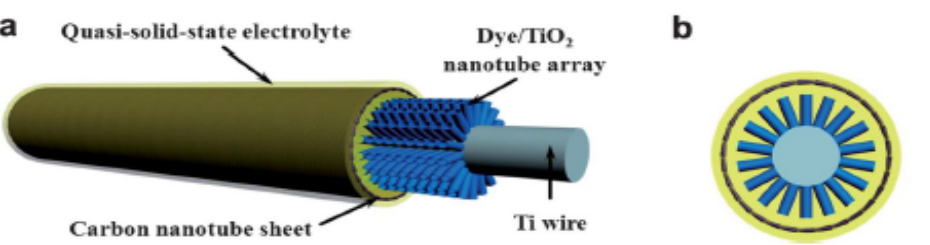
Figure 2. Three-dimensional schematic of a core/shell NW and cross-sectional schematics of four core/shell diode geometries, and SEM image of an as-grown, core/shell p/in Si NW, scale bar = 100 nm ( a ), and TEM image of a NW cross-section showing a core surrounded by crystalline shell, scale bar = 50 nm ( b ). Reprinted with permission from reference [73].